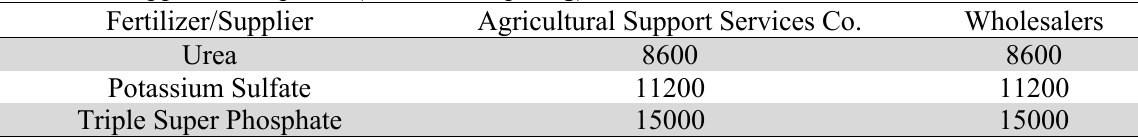
Fertilizers' suppliers and prices (Iranian Rial per kg) Fertilizer/Supplier Agricultural Support Services Co.